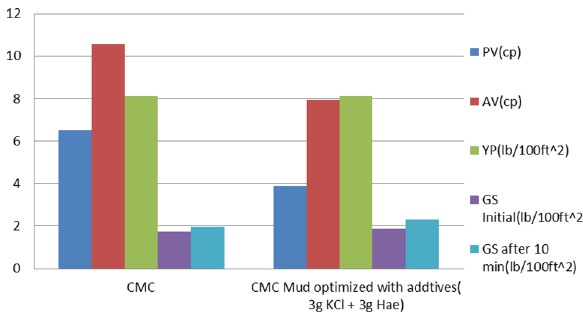
Fig. 25 Rheological properties of non-optimized vs optimized CMC– bentonite mud